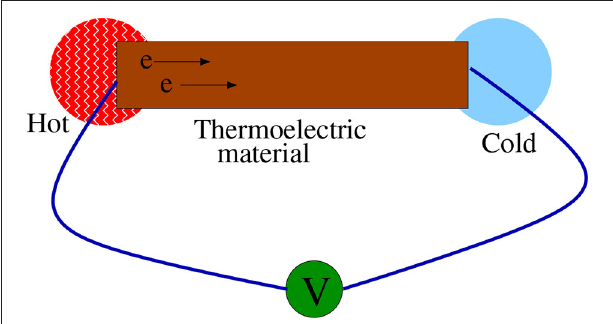
FIGURE 1 | Seebeck-Peltier effect. Electric and thermal currents are the response to small voltage and temperature differences. Their interference is described by symmetric Onsager transport